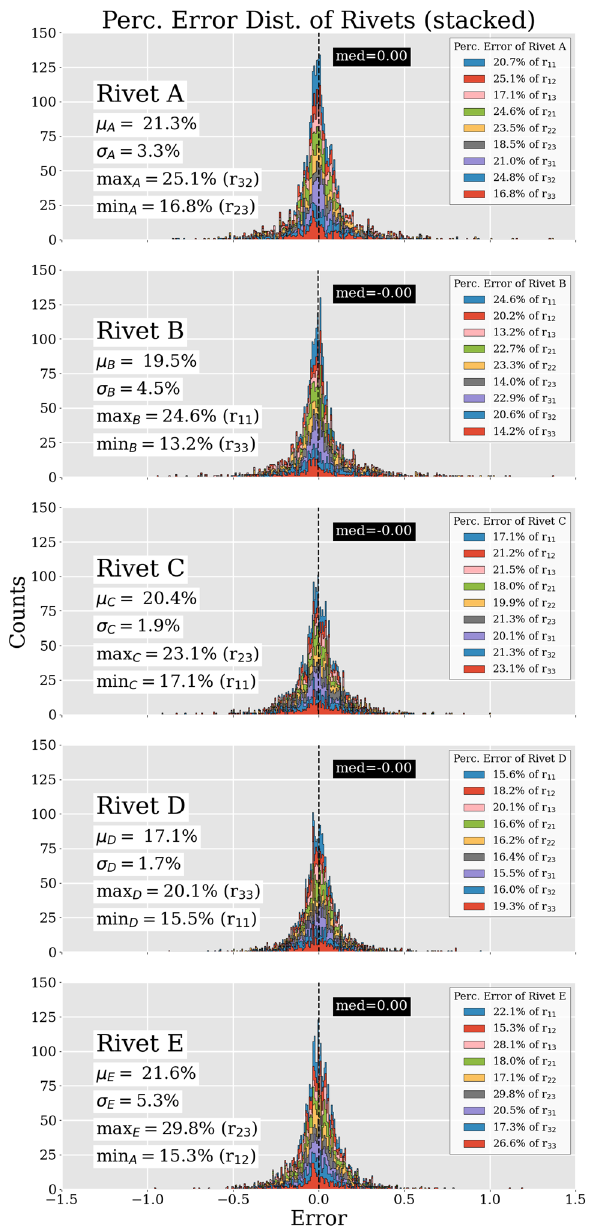
Fig. 8 Percentage error of rivets (Mix4 test data set) of the respec- tive matrix entries. Here we see both the mean contribution of each rivet to the entire error ( 𝜇 , 𝜎 ) and their contribution to each matrix entry ( r 11 – r 33 ) including their respective maximum and minimum contribution (max,